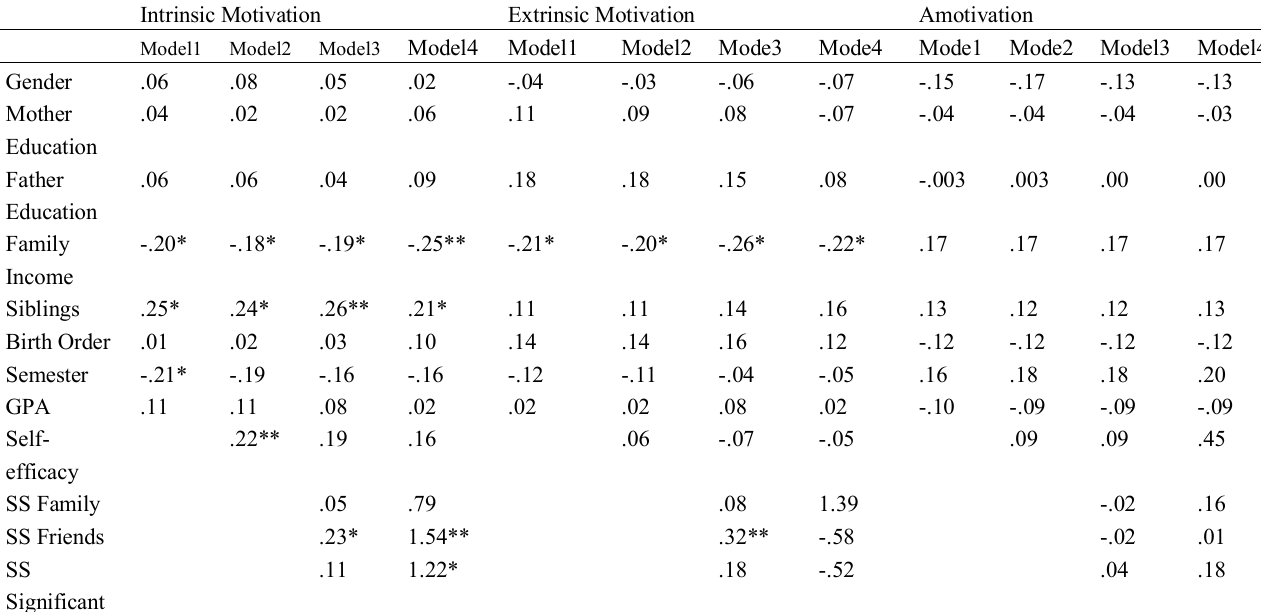
Coefficients from Hierarchical Regression Analyses for Predicting Intrinsic motivation, Extrinsic Motivation, and